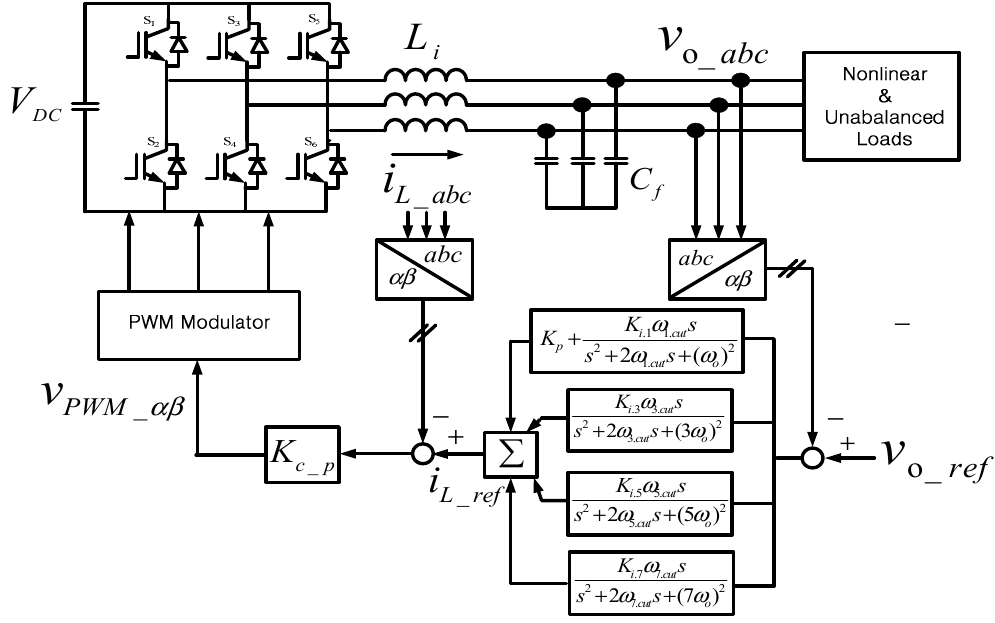
Figure 2. Configuration of P+MR controller in islanded mode.